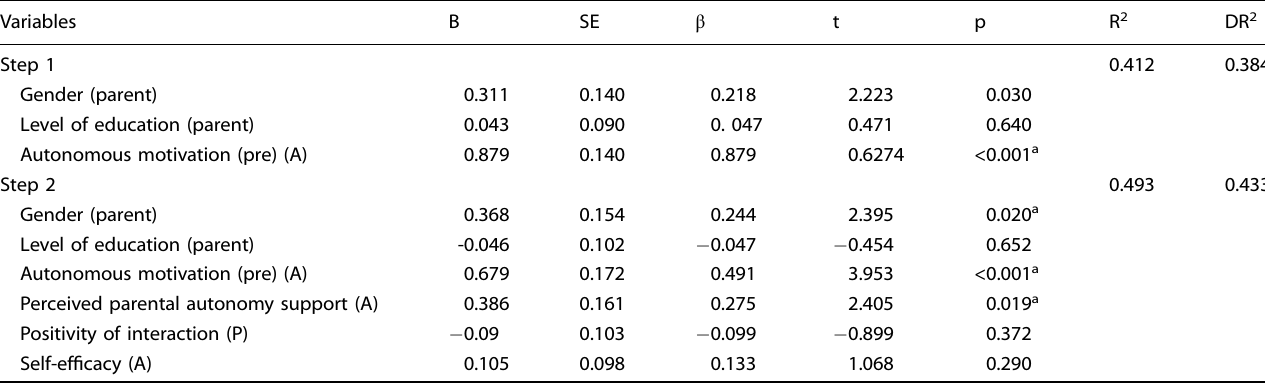
Table 3. Stepwise regression analysis of three basic psychological needs of the self-determination theory on autonomous motivation during home- based learning ( N = 76 parent-adolescent